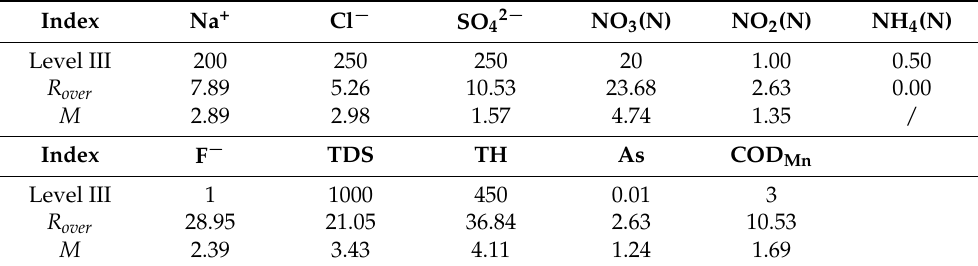
Table 6. Statistics of the overstandard indices.